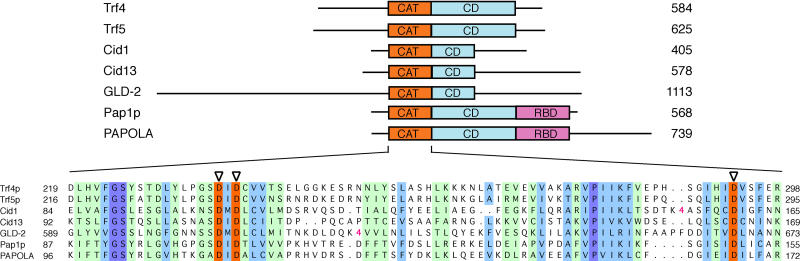
Schematic Alignment of the Domain Organization of Trf4p and Trf5p with Other Members of the Pol-β-like Nucleotidyltransferase FamilyThe proteins are represented as lines, with conserved regions shown as boxes (CAT, catalytic domain; CD, central domain; RBD, RNA-binding domain; sizes in amino acids are indicated to the right). The green boxes in the sequence alignment mark regions with 50% similarity, light blue boxes indicate 100% similarity, and dark blue and orange boxes are regions with 100% identity. The three conserved catalytic aspartates at positions 236, 238, and 294 are in orange and marked by triangles. Regions with four additional amino acids present in Cid1 and GLD-2 are marked with a orange “4.”